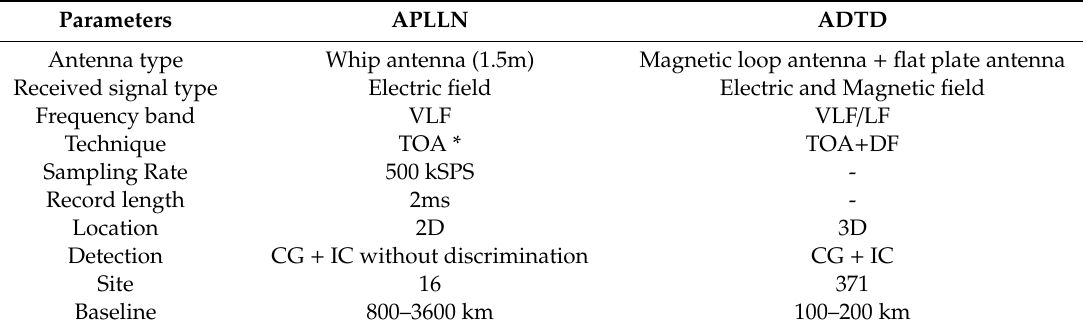
Table 1. Comparison of detection network parameters.